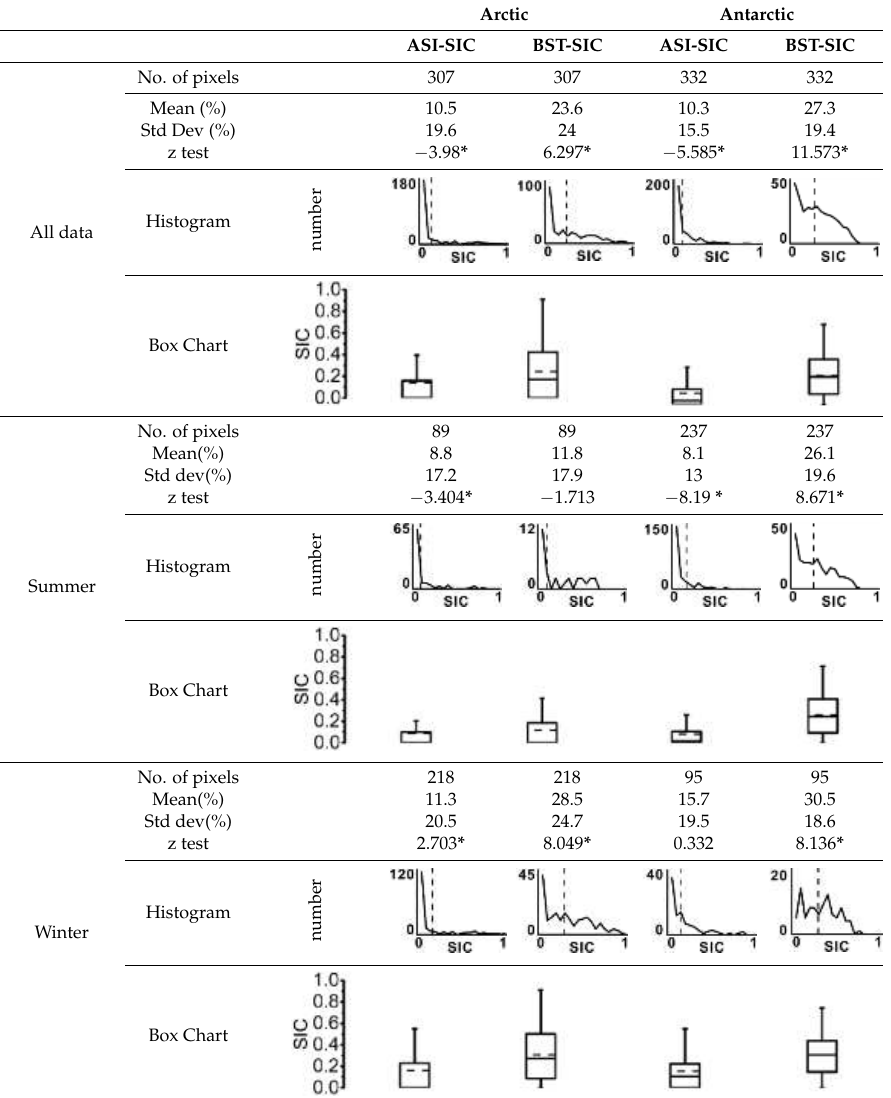
* Statistically significant at the 0.05 level.